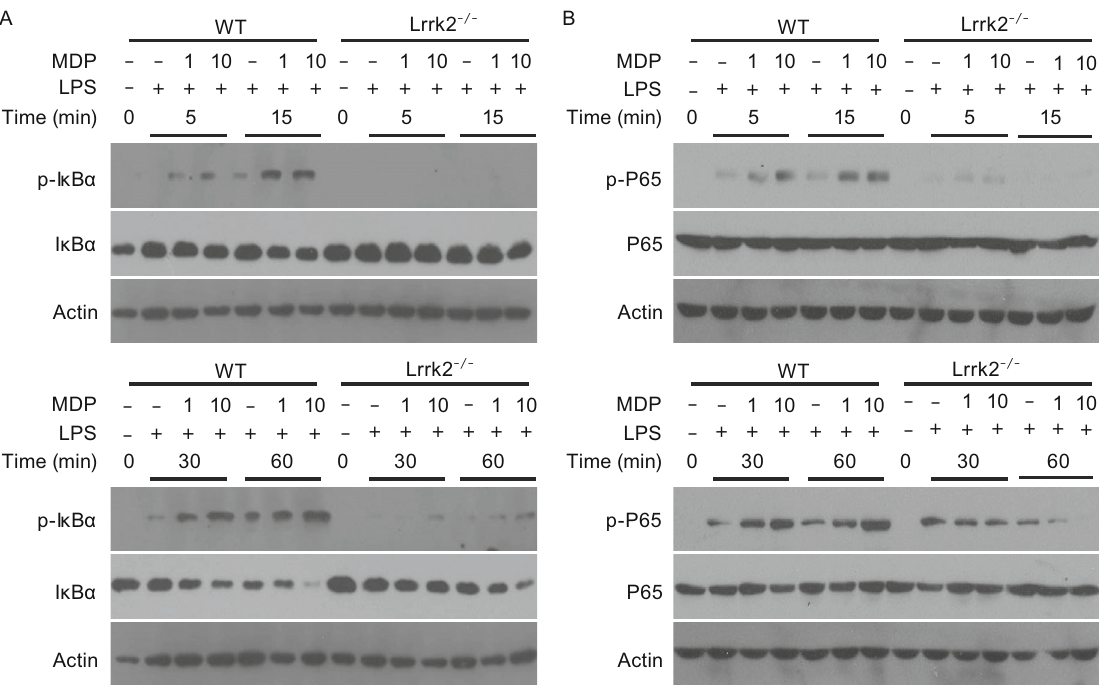
Figure 2. LRRK2 modulates NF- κ B activation in BMDMs. The levels of phosphorylated I κ B α (A) and phosphorylated P65 (B) were monitored in WTand Lrrk2 − / − BMDMs treated with 5 ng/mL LPS and 1 or 10 μ g/mL MDP for the indicated times. The total amounts of I κ B α (A) and P65 (B) were also analyzed. Actin was used as a loading control. Data are representative of three independent experiments (A,